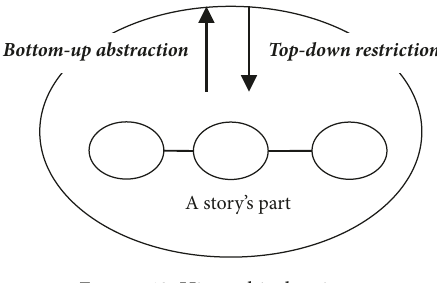
Figure 10: Hierarchical